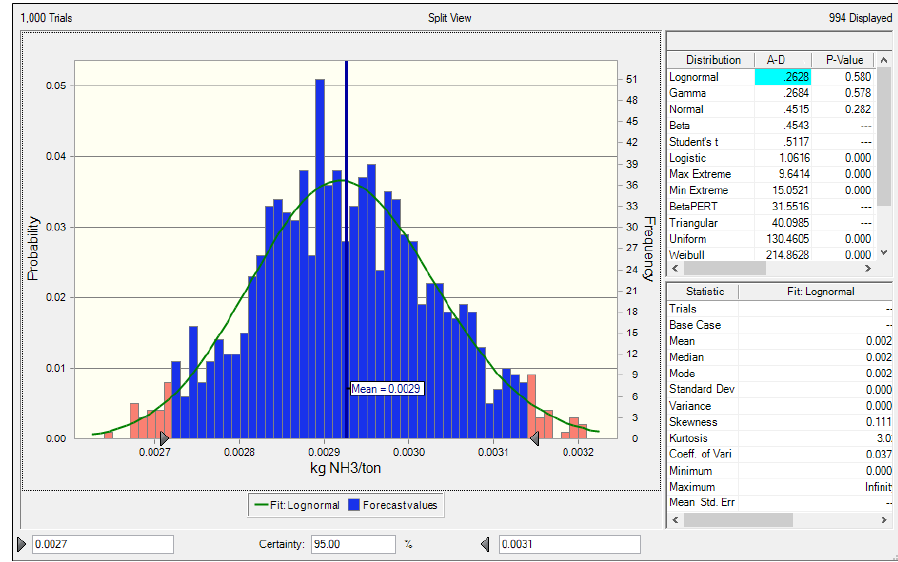
Figure 5. Process of the Monte Carlo Simulation for estimating the uncertainty of the emission factor.